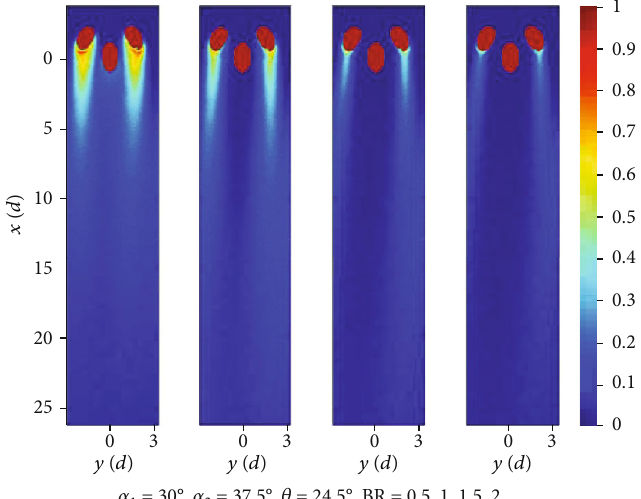
Figure 13: Film cooling e ff ectiveness distributions downstream of the branched holes, α